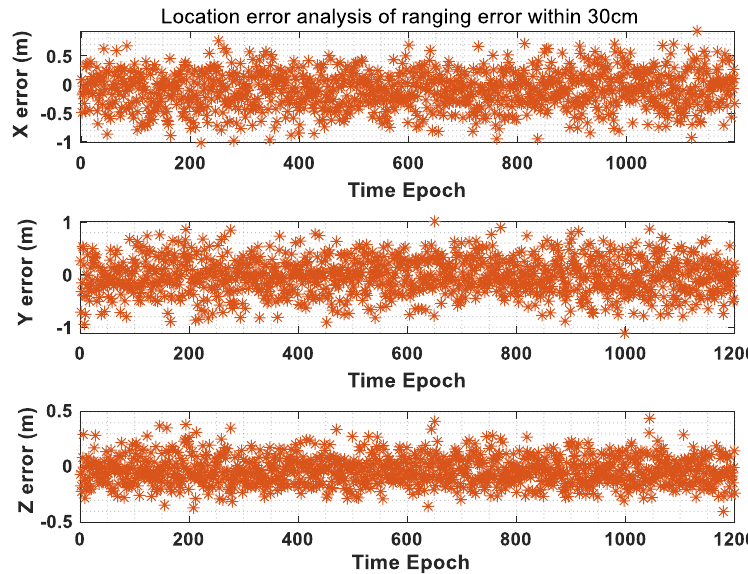
Figure 12. Positioning accuracy analysis when ranging accuracy is within 30 cm.